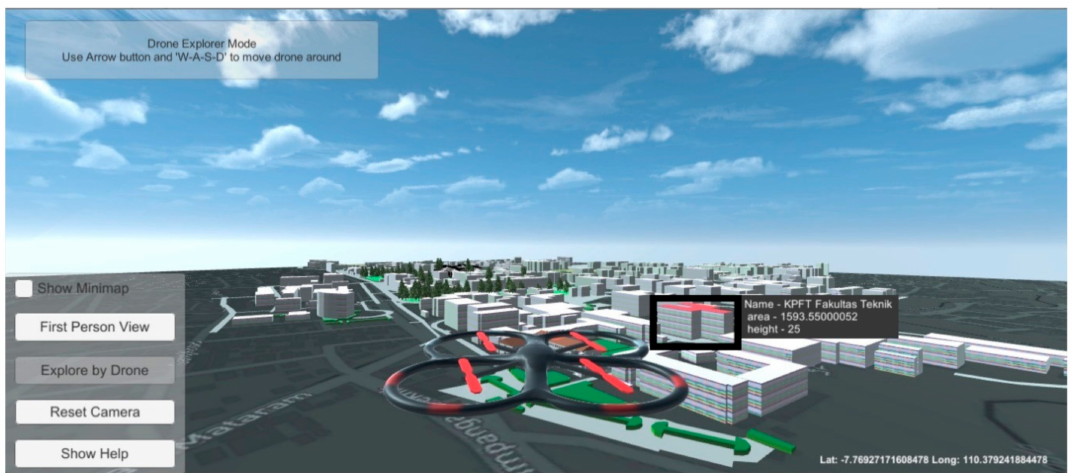
Figure 11. Drone view for air-based